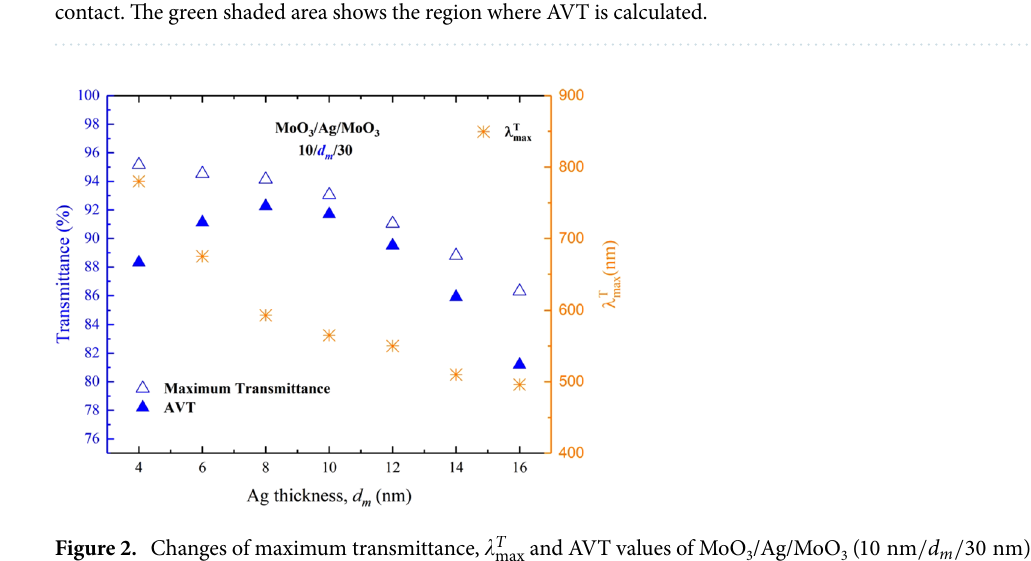
Figure 2. Changes of maximum transmittance, (cid:31) T max and AVT values of MoO 3 /Ag/MoO 3 ( 10 nm / d m / 30 nm ) DMD transparent top contact according to d m